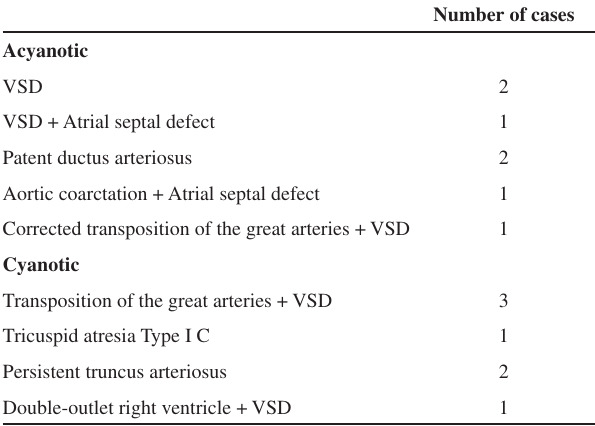
Table 1 - Diagnoses in congenital heart defects, according to SaO above (Acyanotic) and below (Cyanotic) 90% 2